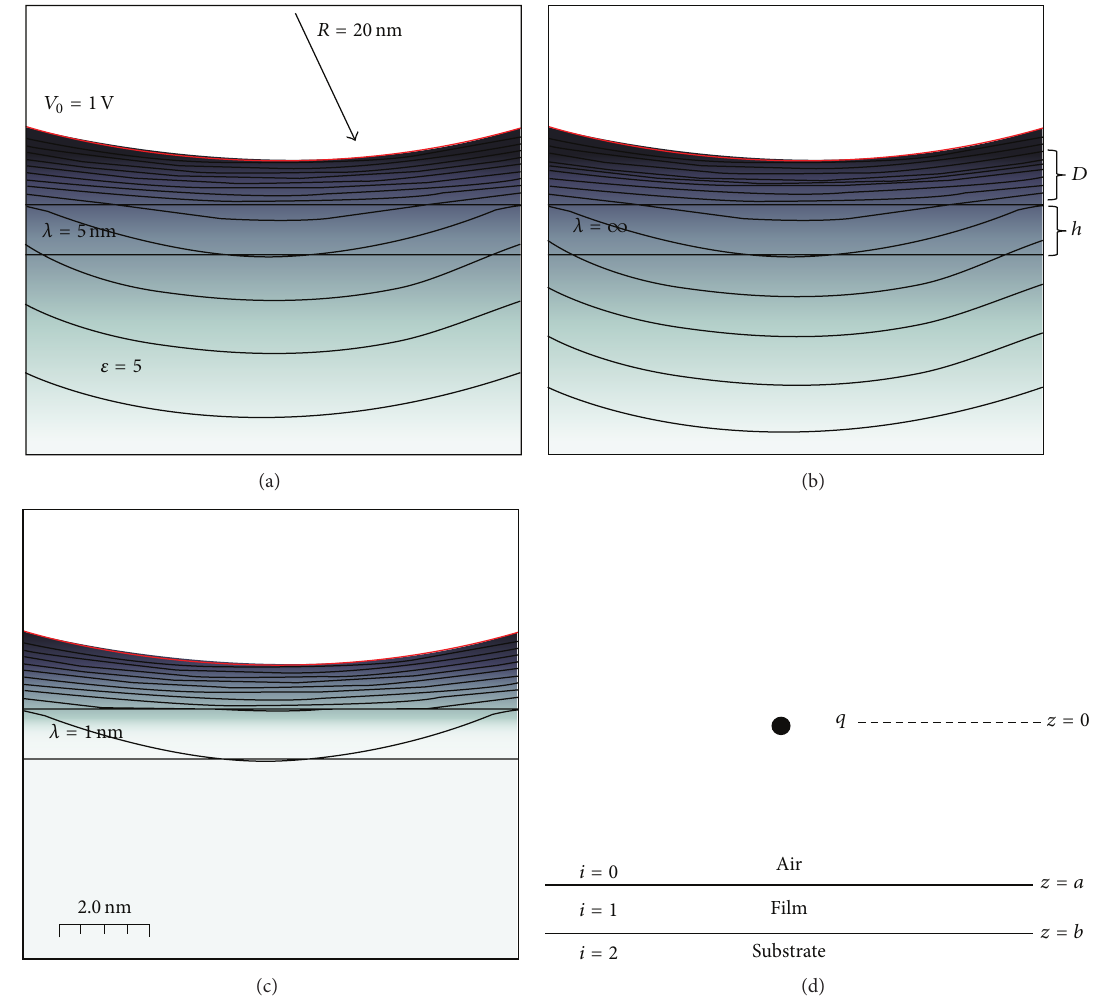
Figure 1: Equipotential distribution of the tip-sample system in Electrostatic Force Microscopy for 3 different thin film screening lengths. The arrow shown in the potential distribution shows the region that has been